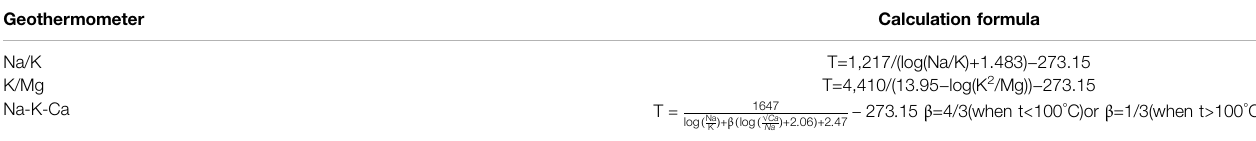
TABLE 3 | Formulas for calculation of cationic geothermometers. Geothermometer